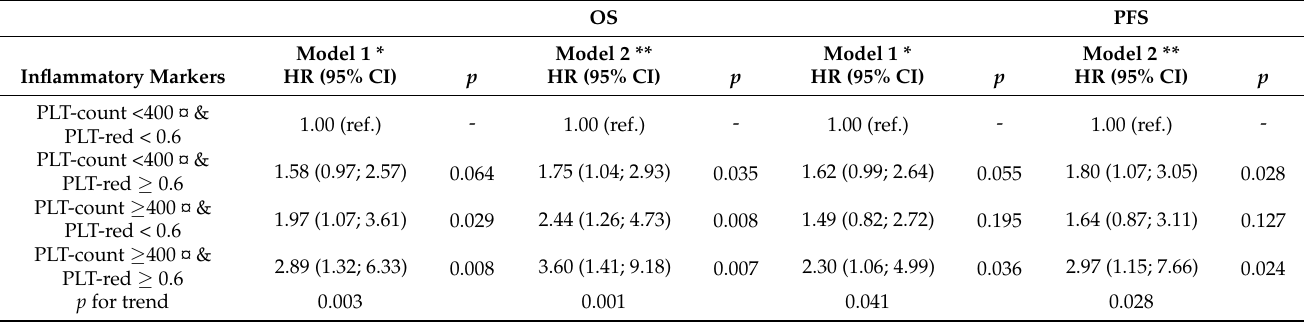
Table 3. Cox regression analysis for groups based on the baseline platelet level and platelet reduction.